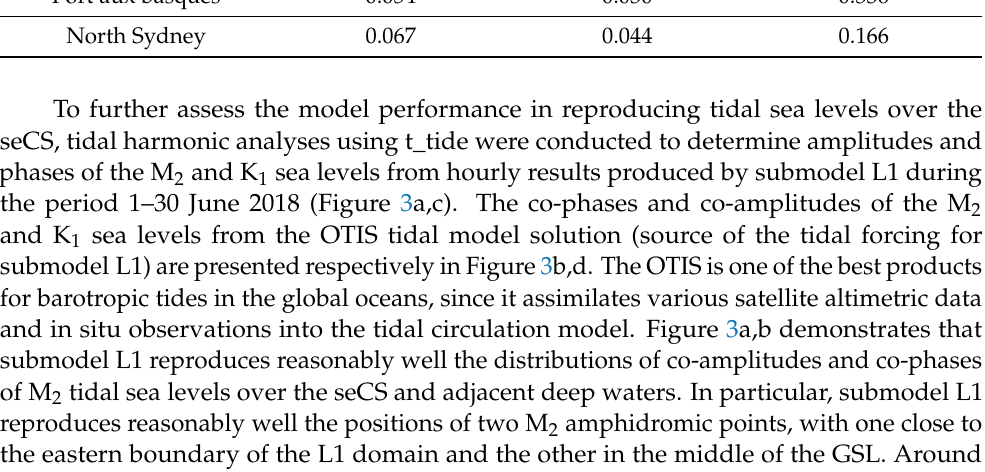
Table 2. List of γ 2 values for total, tidal, and sub-tidal surface elevations.